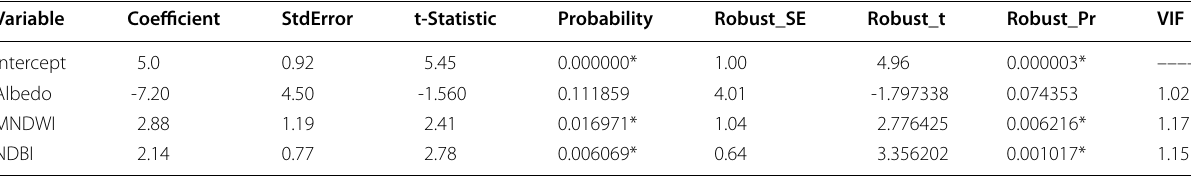
NDVI was found to have a high VIF (> 7.5) and was removed from the regression model. The resulting OLS regression model indicates that LST values are positively correlated with albedo, MNDWI, and NDBI. Probability and Robust Probability (Robust_Pr) indicates a coefficient of NDVI, MNDWI, and NDBI are statistically significant ( p < 0.01) (Table 8). These explanatory variables were only able to explain 46% of the variation in the observed LST patterns (Multiple R-Squared